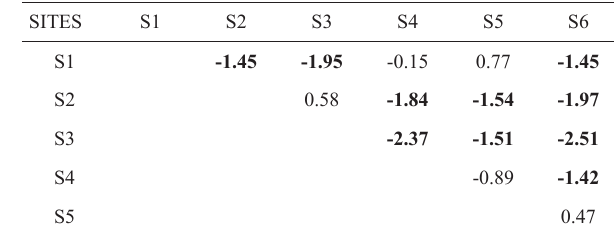
Tab. 2. Results of the MRPP analysis, which compared